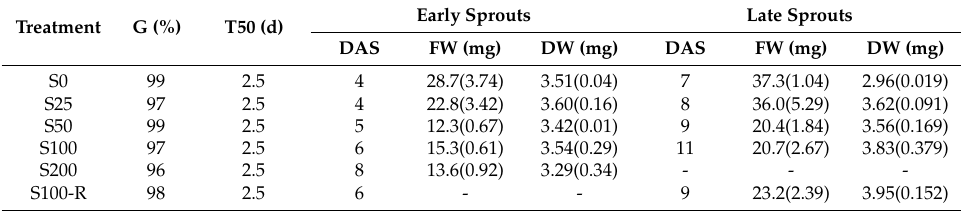
Table 1. Total germination percentage (G), time to reach 50% of G (T50), number of days after sowing (DAS) needed to reach the early sprout and late sprouts stages fixed for harvest (i.e., before and after cotyledon expansion), and correspondent individual sprout fresh (FW) and dry weights (DW) in rapeseed sprouted and grown with salt (NaCl) concentration 0, 25, 50, 100, 200 mM (S0, S25, S50, S100, S200, respectively) or sprouted with 100 mM and then grown with distilled water as recovery treatment (S100-R). Standard error in